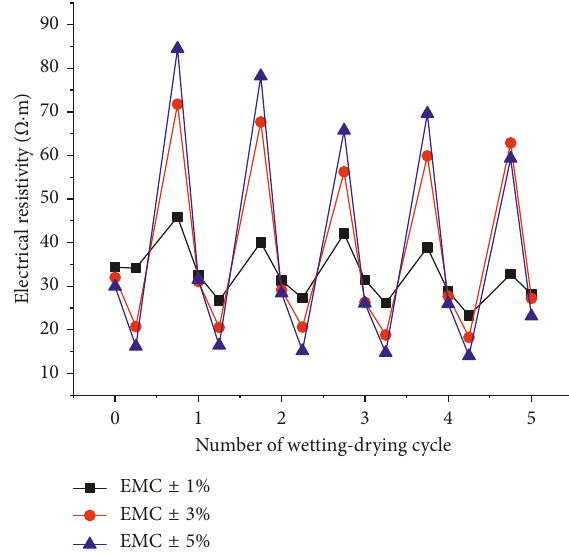
Figure 11: Evolutions of soil electrical resistivity with wetting- drying Figure 12. Overall, the electrical resistivity of soil decreases